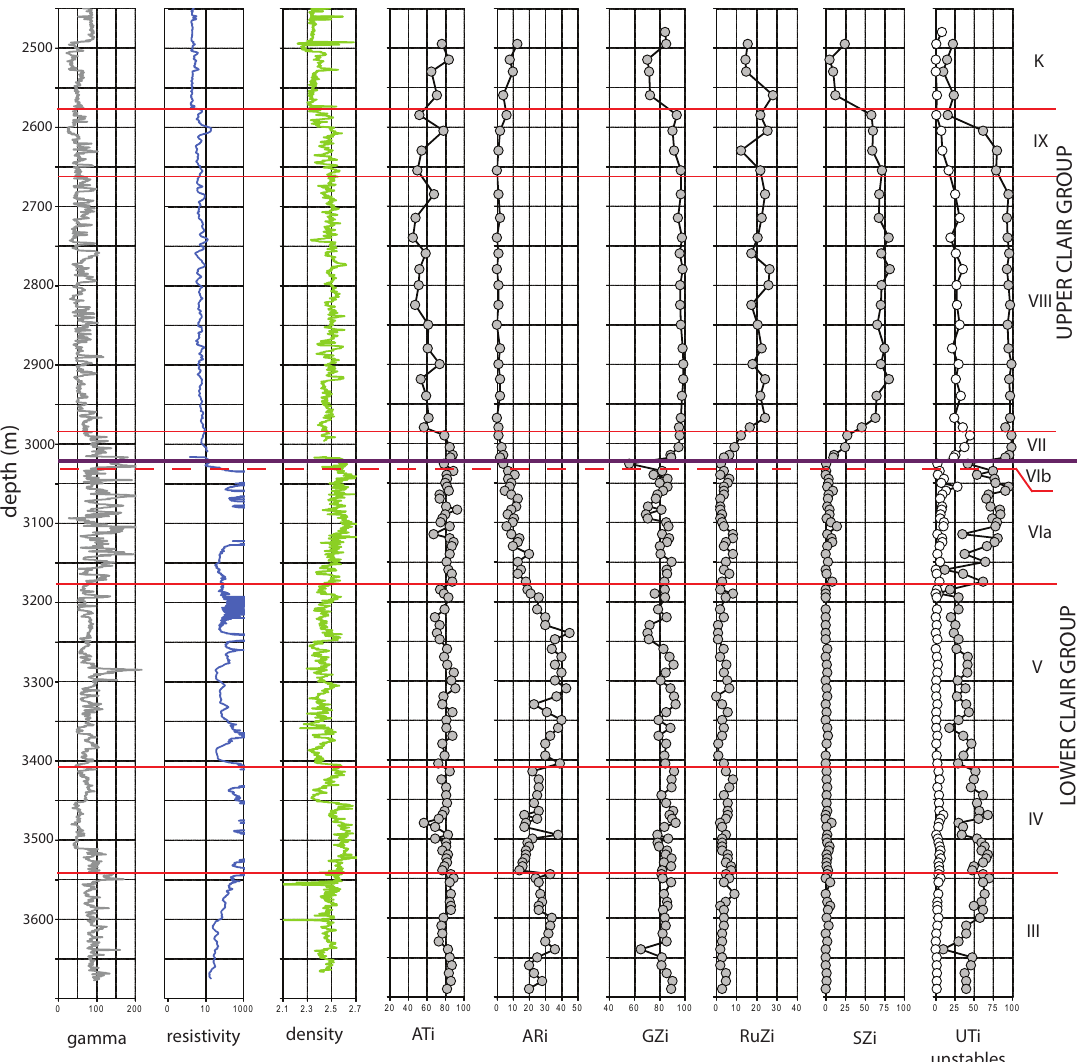
Figure 14. Variations in heavy mineral parameters acquired at the well site during drilling of the high-angle well 206/8-A16, Clair Field, west of Shetland, together with the interpreted stratigraphy. Note the highly anomalous resistivity log responses in units IV, V, and VIa, caused by extensive mineralisation. Well location is shown in Figure 1 and the geological interpretation along the well track is shown in Figure